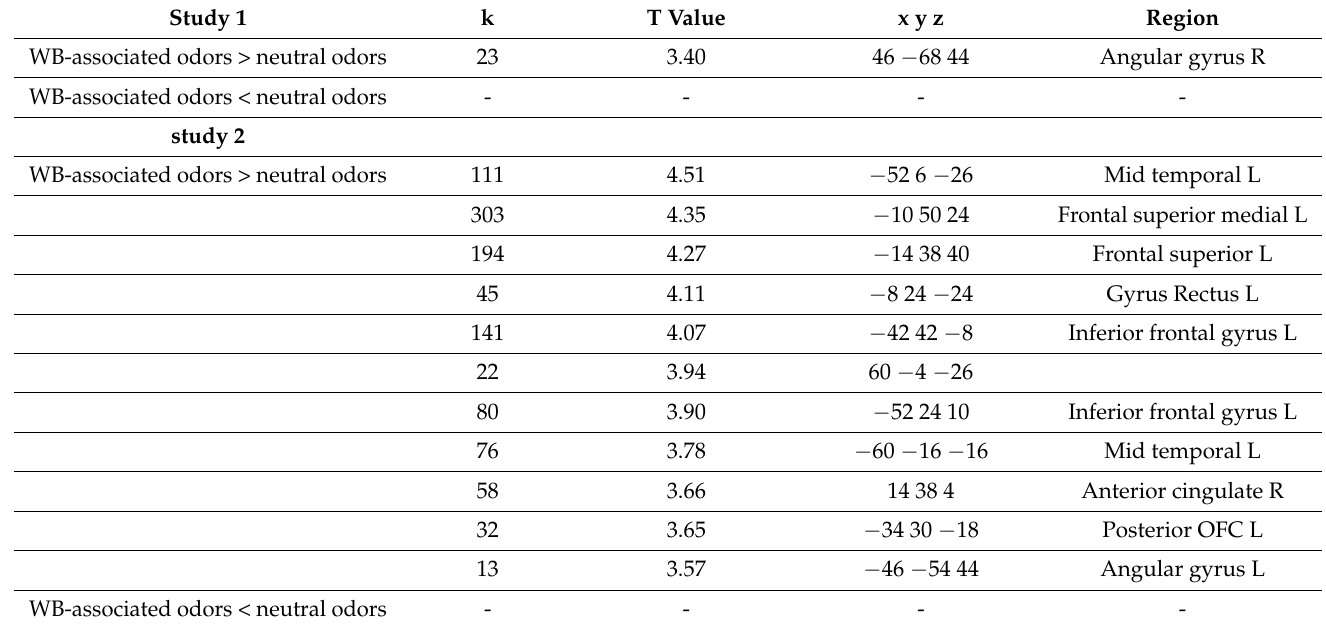
Table 2. Regions activated for WB-associated contrast odors > neutral odors for study 1 and 2. Effect seen at p uncorrected < 0.001 and a cluster size of k > 10 voxels; MNI coordinates are presented in x, y, and z; L, left hemisphere; R right